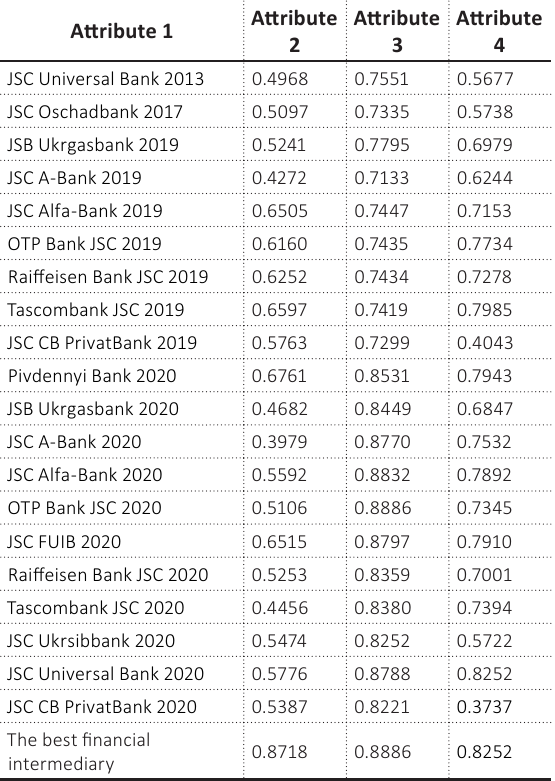
Table 14. Financial intermediaries of the newly formed pattern C7